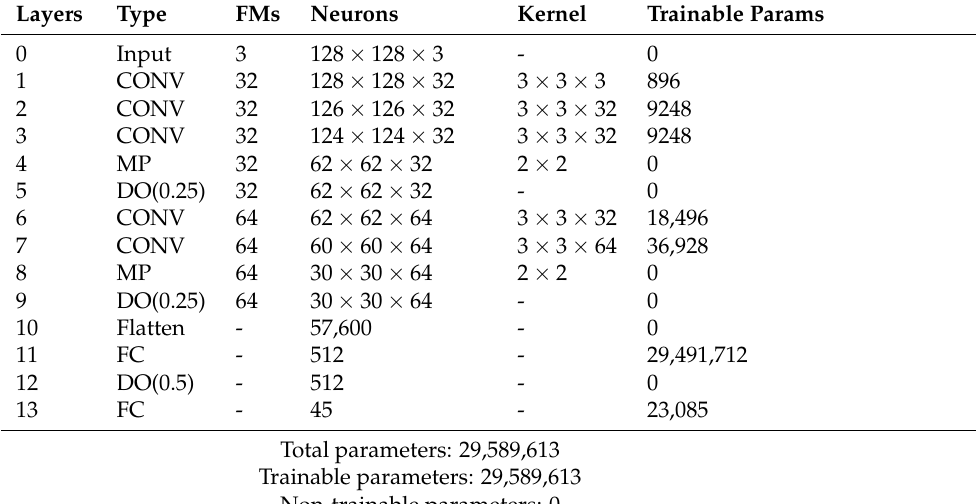
Figure 4. The layers of the proposed ML-CNN model. Table 4. The proposed ML-CNN